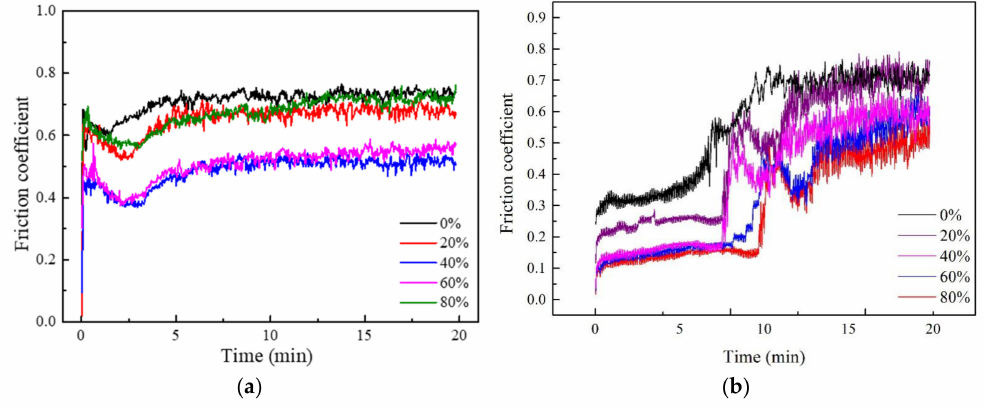
Figure 11. Friction coefficient curves of alloy samples with different deformation degrees after nitriding. ( a ) After cold rolling and ( b ) after